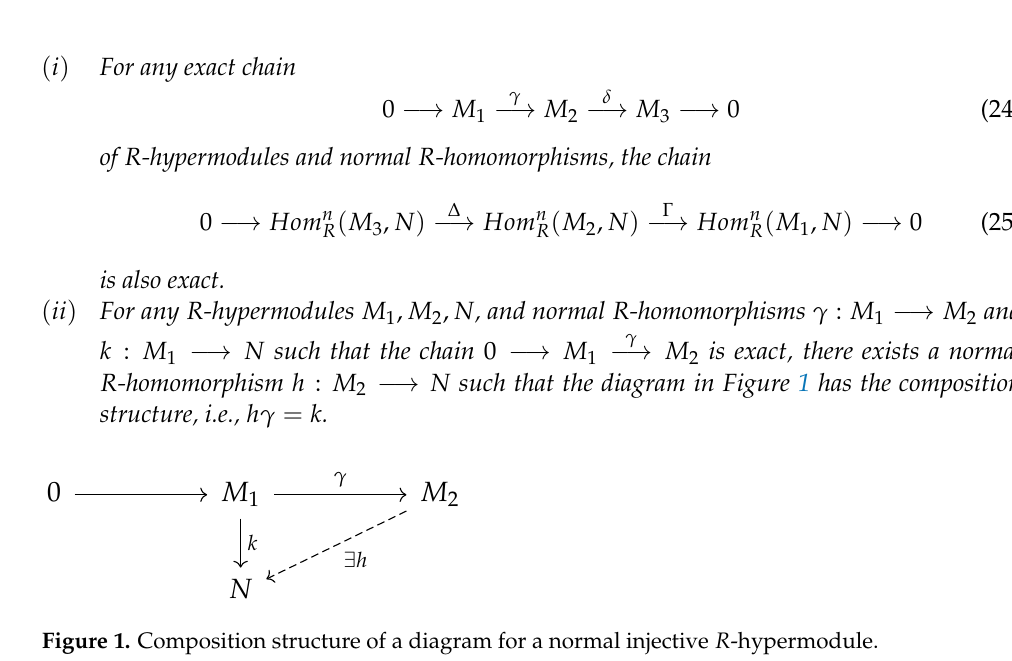
Figure 1. Composition structure of a diagram for a normal injective R -hypermodule